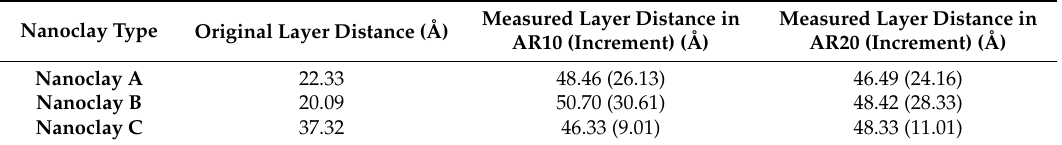
Table 10. Layer distance of nanoclay before and after mixed with